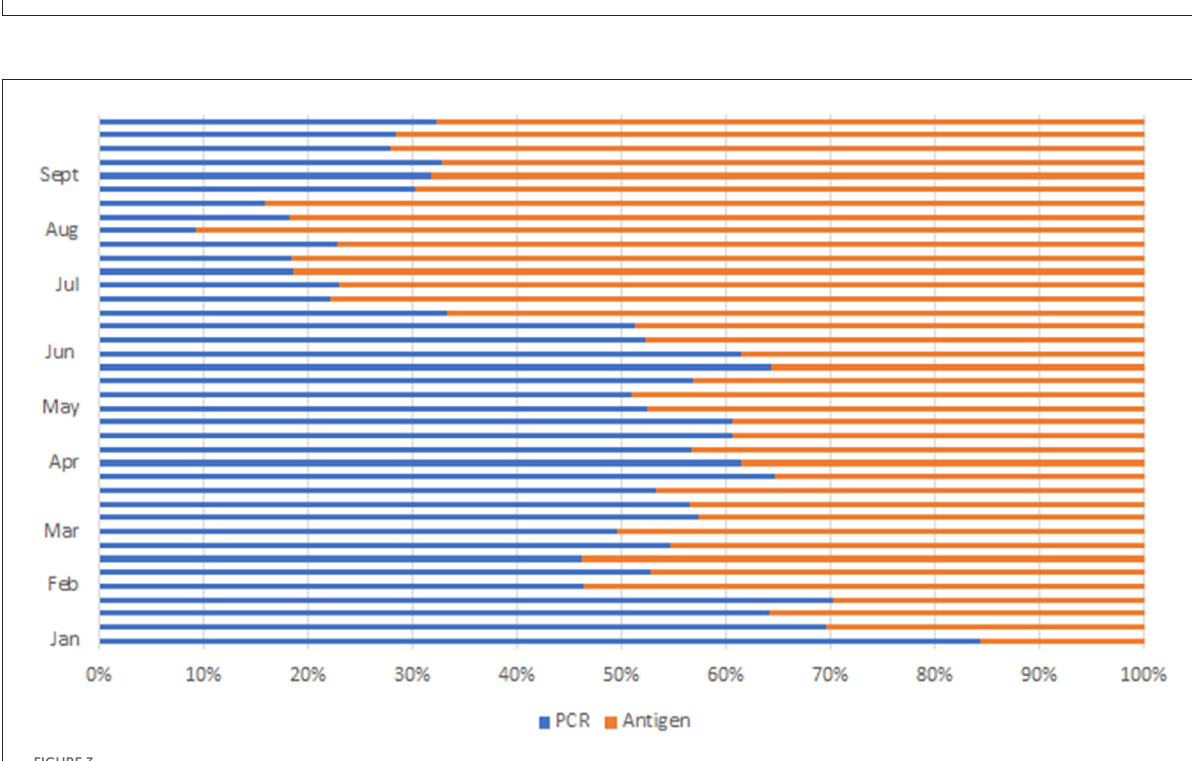
FIGURE3 Proportion of antigen RDT tests to PCR by month in